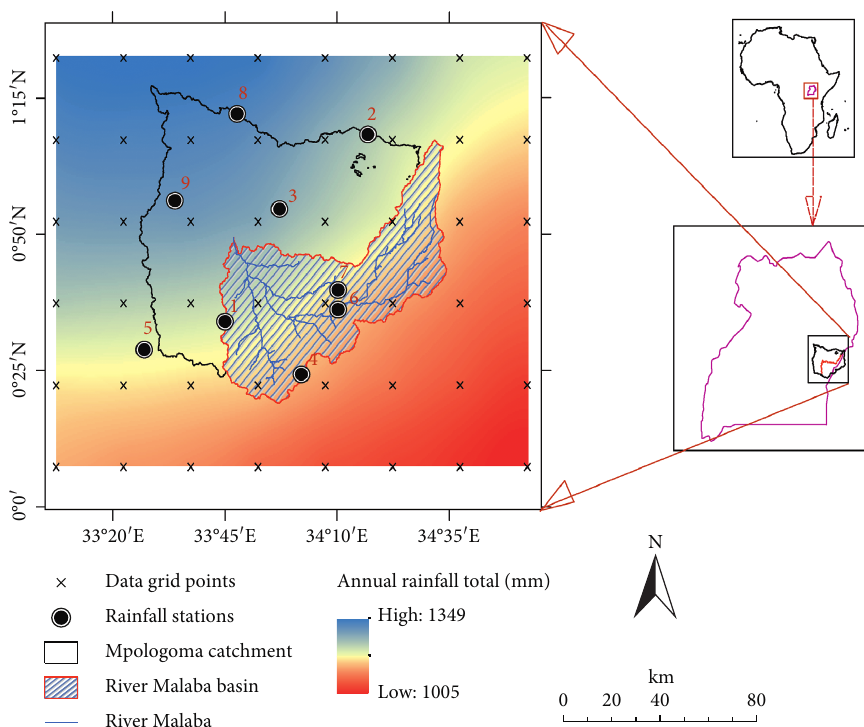
Figure 1: Location of the study area showing the data grid points and locations of the selected rainfall stations detailed in Table 1. Surface interpolation by the ordinary kriging technique was used to obtain the background map from the annual rainfall total (mm) of